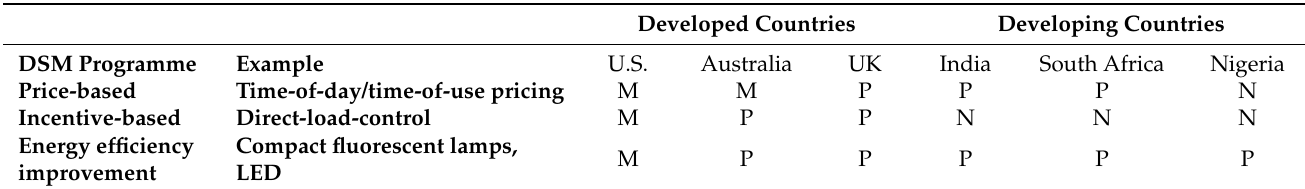
Table 10. Comparison of DSM